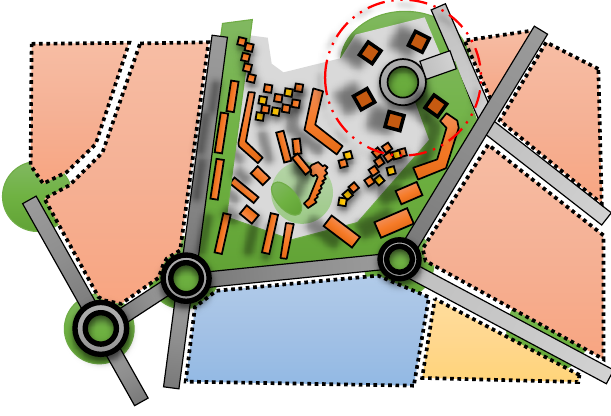
Fig. 1. Urban design of Ulpiana